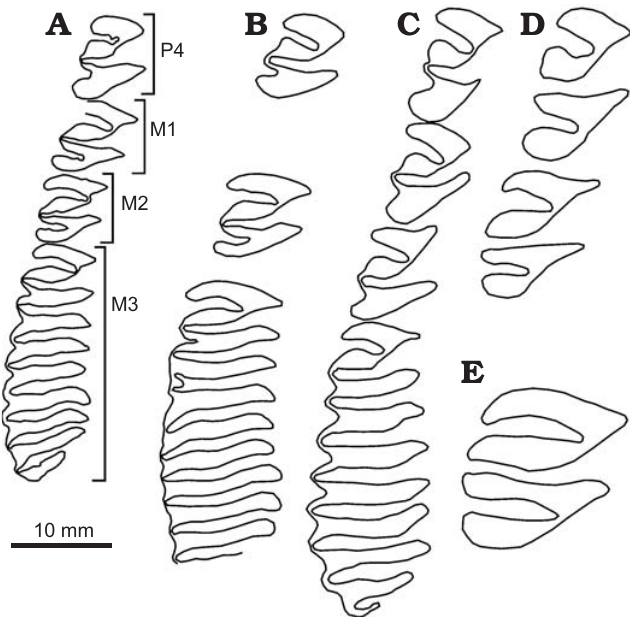
Fig. 5. Schematic occlusal view of upper teeth of Cardiatherium (A–C) and Phugatherium (D–E). A . Cardiatherium calingastaense sp. nov. (late Miocene, Puchuzum, San Juan Province, Argentina), INGEO-PV 87, right P4–M3. B . Cardiatherium patagonicum (late Miocene, Estancia Rincón Chico, Chu but Province, Argentina), MPEF-PV 740/22, reversed left P4; MPEF-PV 740/23, reversed left M1 or M2; MPEF-PV 740/18, right M3. C . Cardiatherium paranense (late Miocene, Ituzaingó Formation, Entre Ríos Province, Argentina), MLP 87-XI-1-27, right P4–M3. D . Phugatherium novum (middle Pliocene, Chapadamalal Formation, Buenos Aires Province, Argentina), MMP 492-S, right P4–M1. E . Phugatherium cataclisticum (late Miocene–Early Pliocene, Monte Hermoso Formation, Buenos Aires Province, Argentina), MLP 15-231a, right M1.